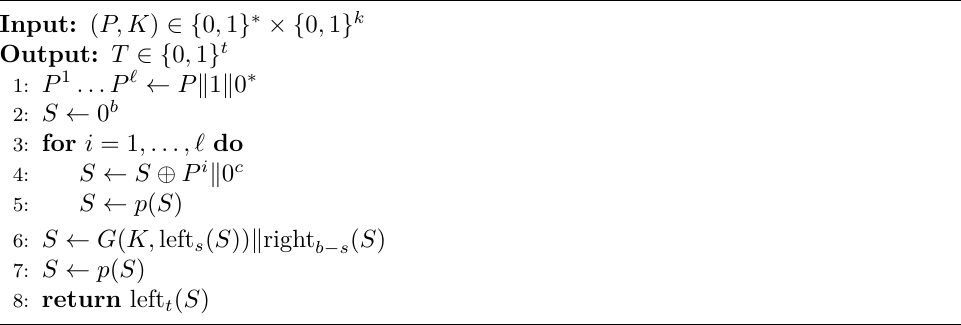
Figure 1: The suffix keyed sponge. The plaintext P is first injectively padded into r -bit blocks P 1 . . . P ‘ . Algorithm 1 Algorithmic description of the suffix keyed sponge